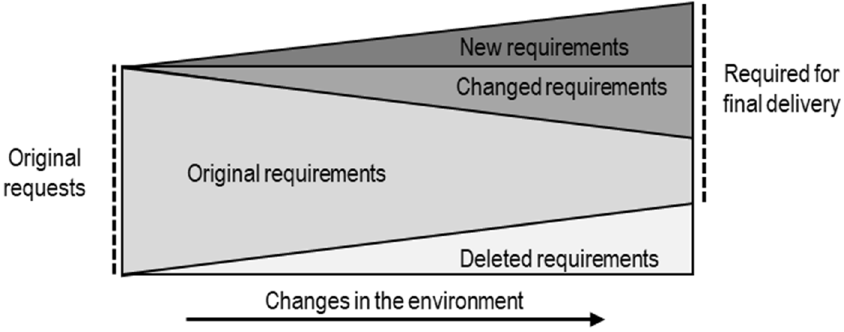
Figure 1. Inevitability of requirement changes [4,5].